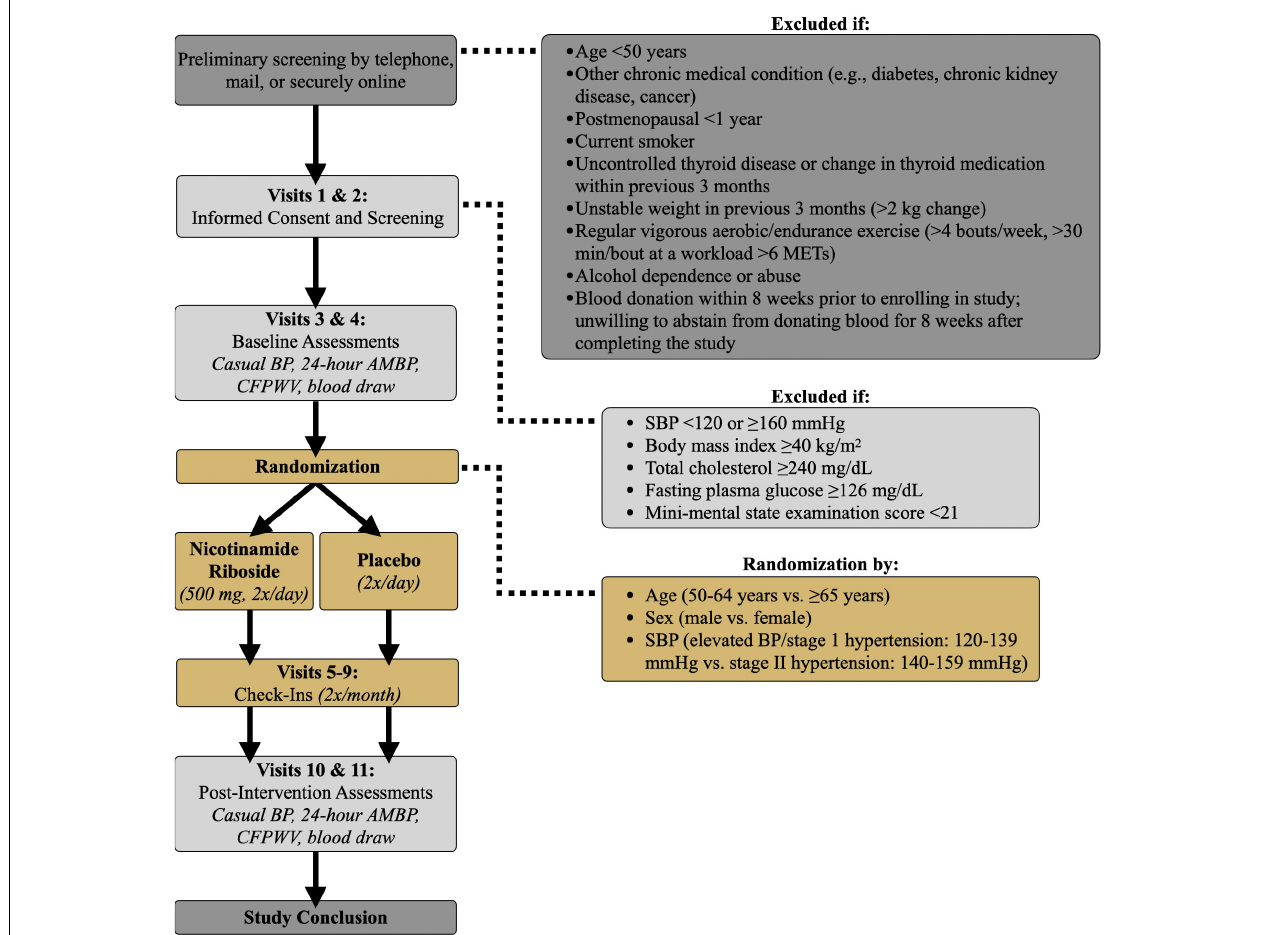
FIGURE 2 | Study design. BP, blood pressure; AMBP, ambulatory blood pressure; SBP, systolic blood pressure; CFPWV, carotid-femoral pulse wave velocity; METs, metabolic